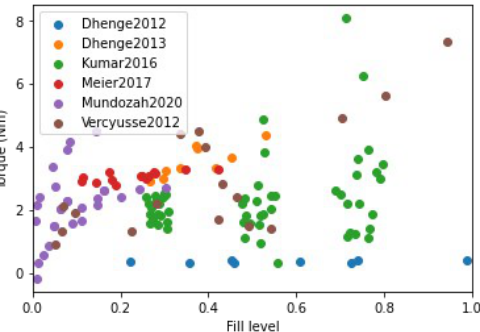
Figure 4. The variation of torque with fill level within the twin screw granulator. The points are color-coded at different L/S ratios. A general increase in torque values is observed with increase in fill level for a constant L/S ratio. [5,15,19,28,35,36]